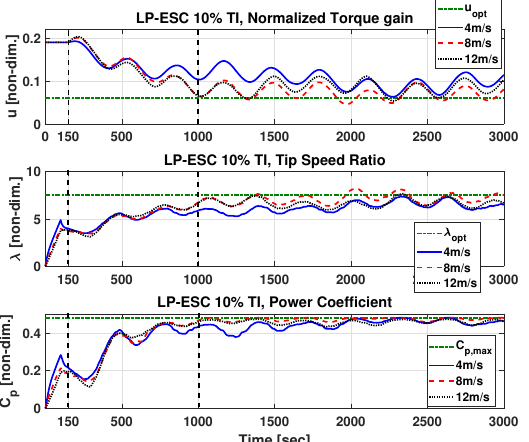
Figure 6. Wind speed time series at hub height: mean wind speeds 4 m/s, 8 m/s, 12 m/s and 10% turbulence intensity.